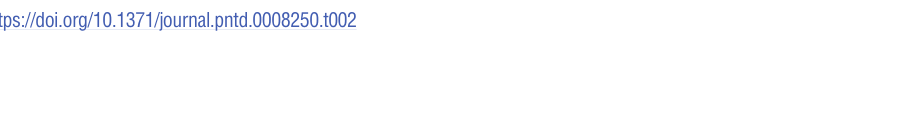
Table 2. Distribution of the different types of breeding sites sampled on the islands of Wallis, Futuna and Alofi. Number of breeding